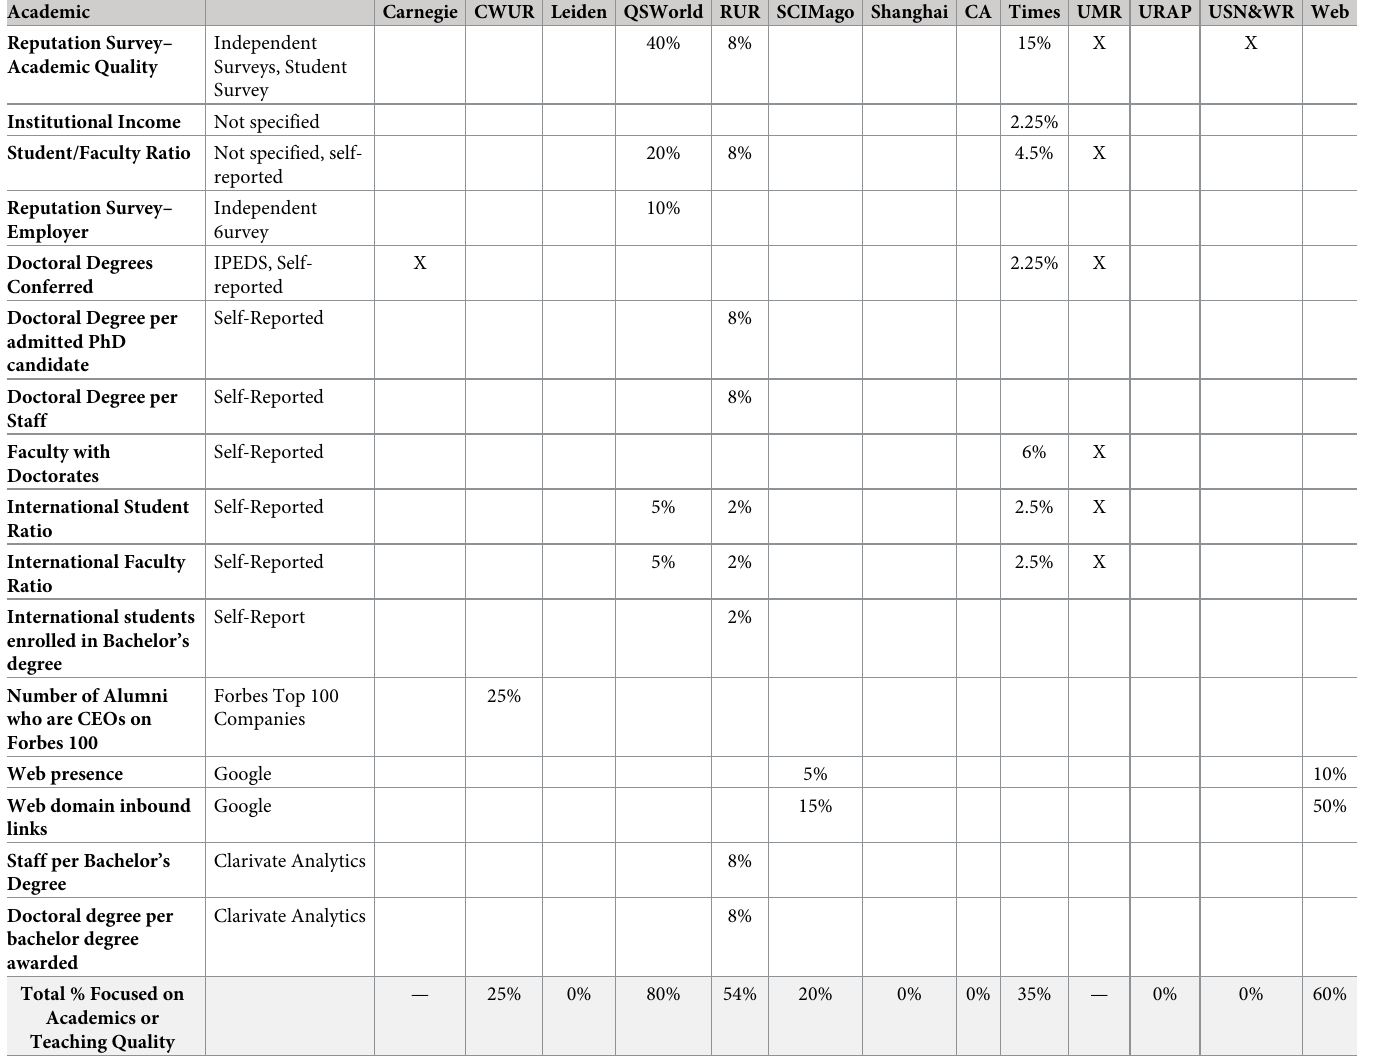
Table 5. Academic quality indicators